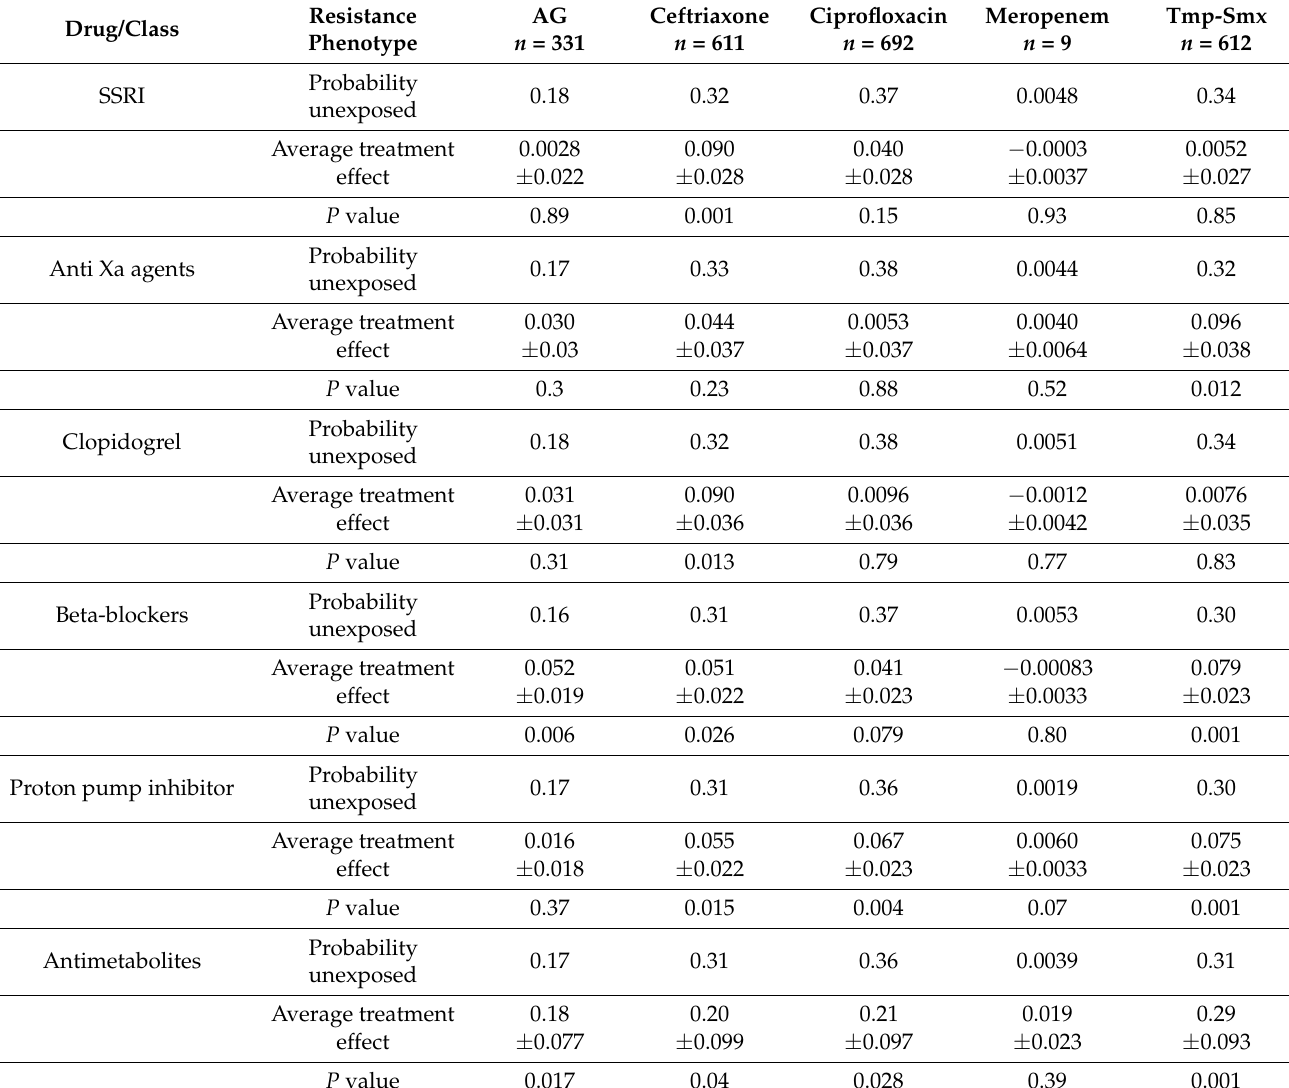
Table 4. Treatment effects